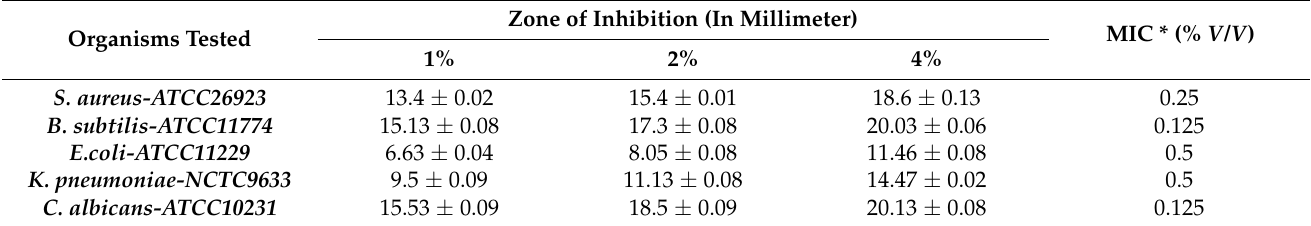
Table 2. Antimicrobial activities of Apium graveolens oil